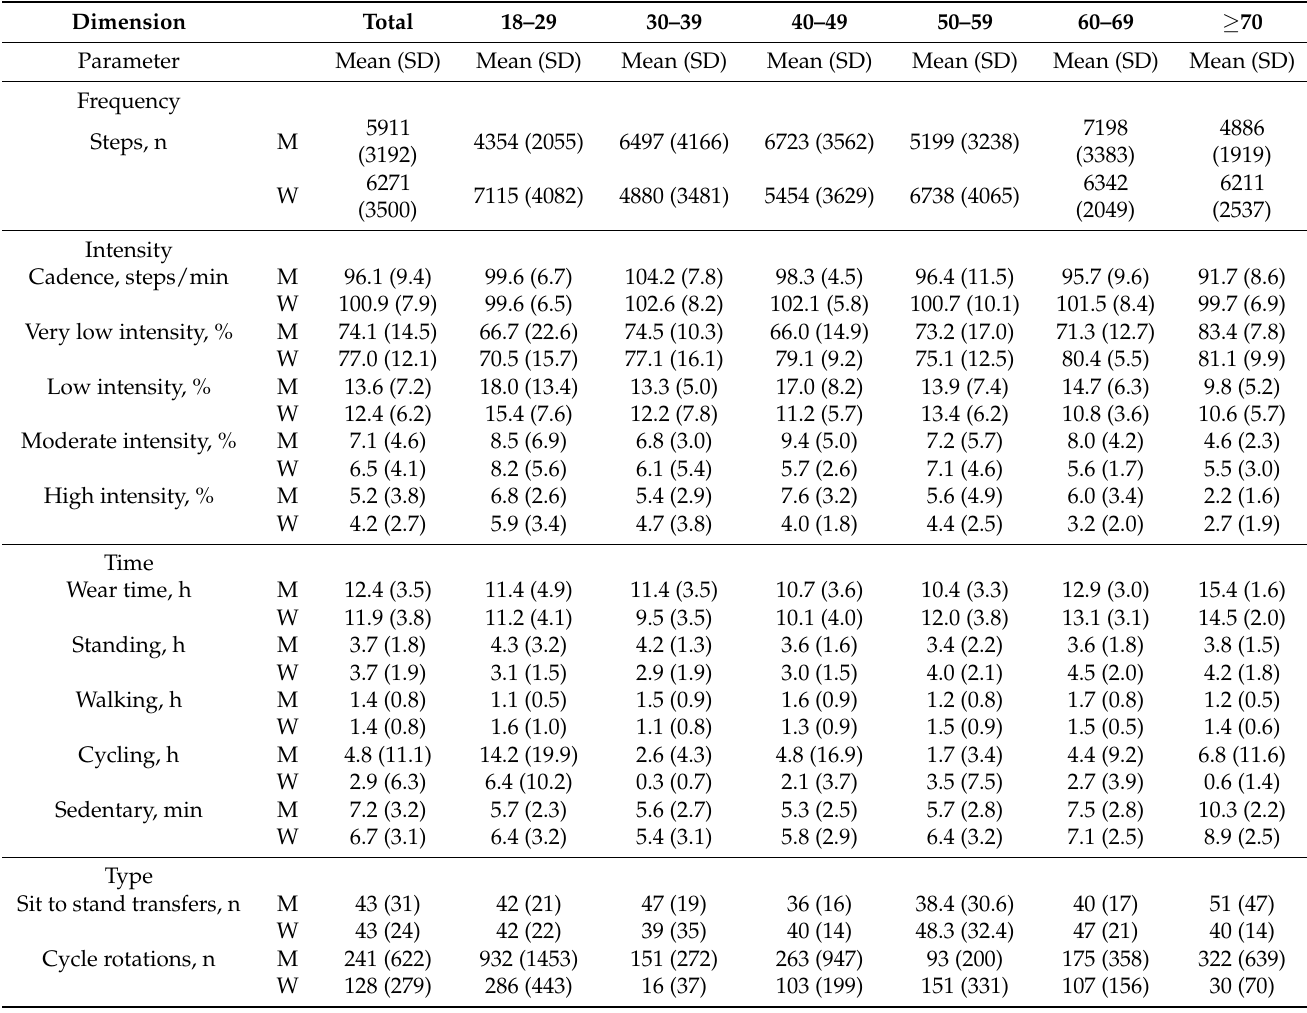
Table 3. Daily Physical Activity According to Age Groups and Stratified by